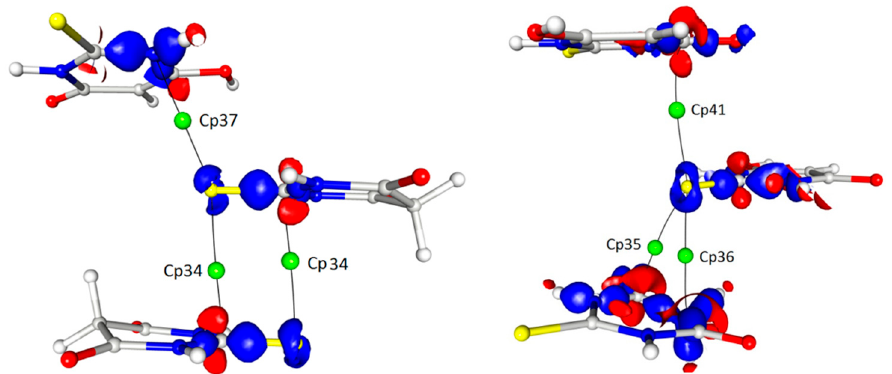
Figure 7. S ··· π in a 3D map of the static electron density view contour 0.225/ − 0.160 with BCPs marked.